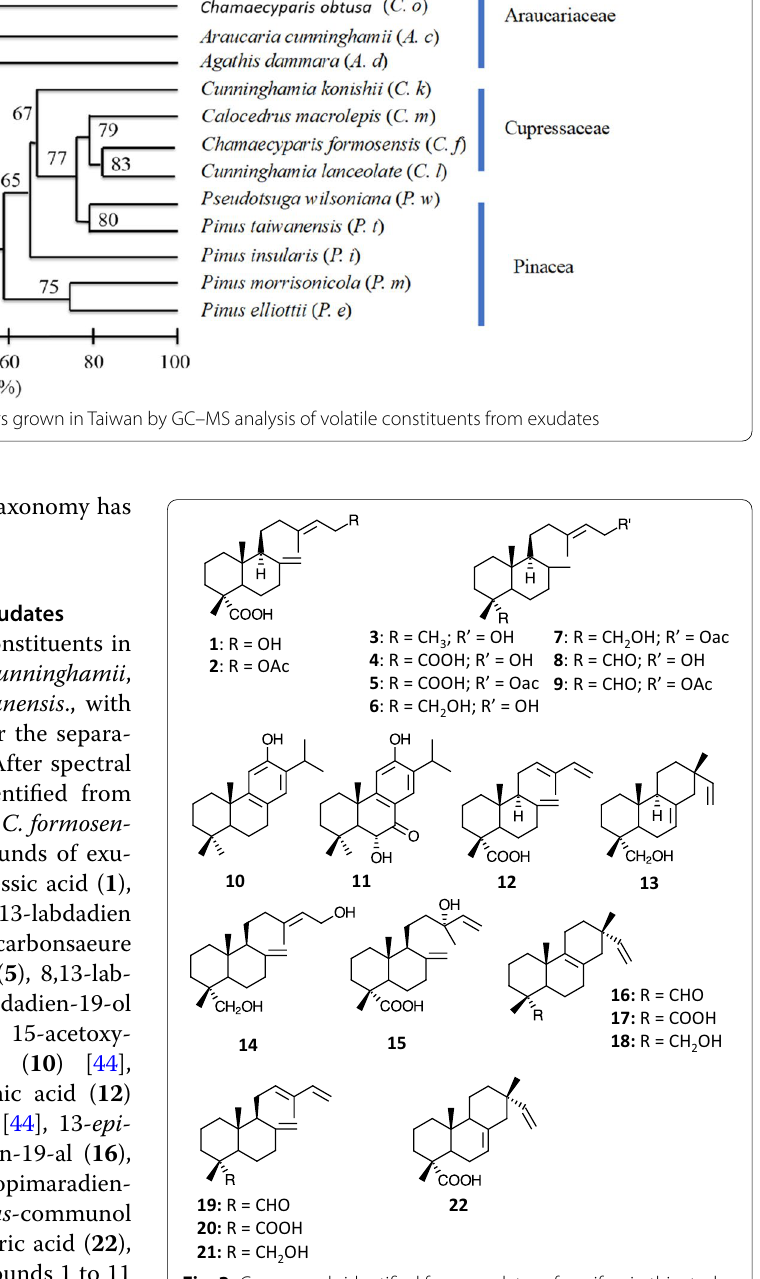
Fig. 3 Compounds identified from exudates of conifers in this